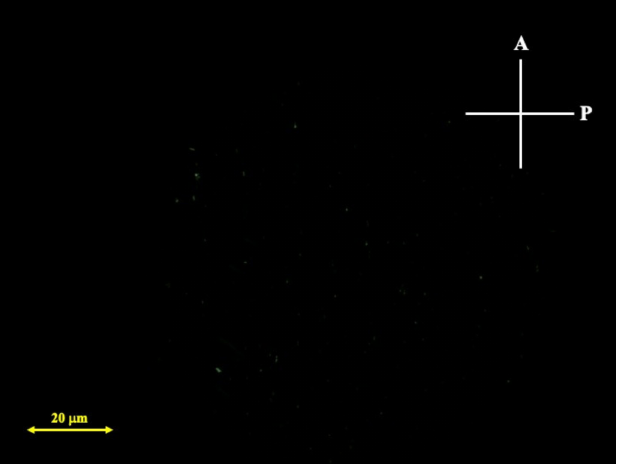
Scheme 1. Texture image under crossed Nicols of the uniformly stacked SSD-LC panel. The photo was taken without applied voltage. With applied voltage under the crossed Nicols condition, light throughput monotonically increases, as shown in Figures 5 and 7, without showing any texture change.